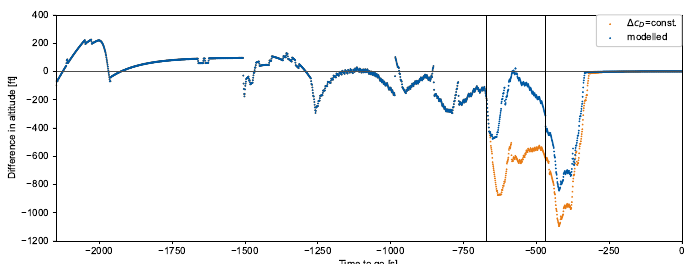
Figure 11. Differences in altitude between a real B748F flight and two modelled flights as a function of time. Blue: modelled with the aircraft-type-specific speed brake model; orange: modelled with ∆ c = 0.02 and ∆ c = 0.00. Vertical lines indicate a time frame of 12 min with significantly deflected D L speed brakes.